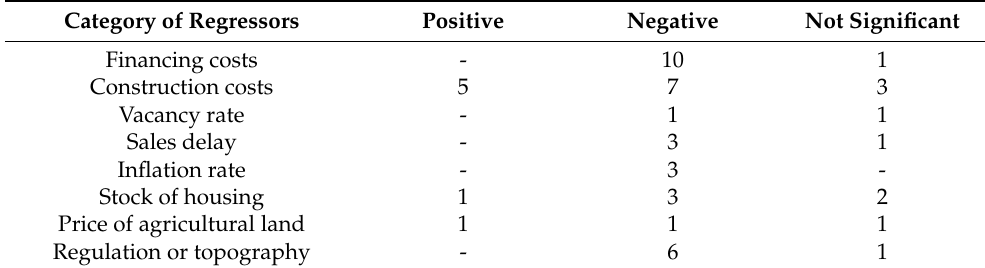
Table 4. Results of the empirical studies by category of